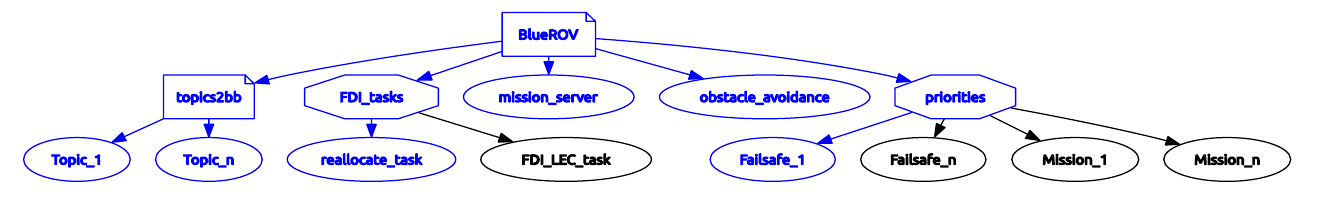
Figure 3. High-level BT in